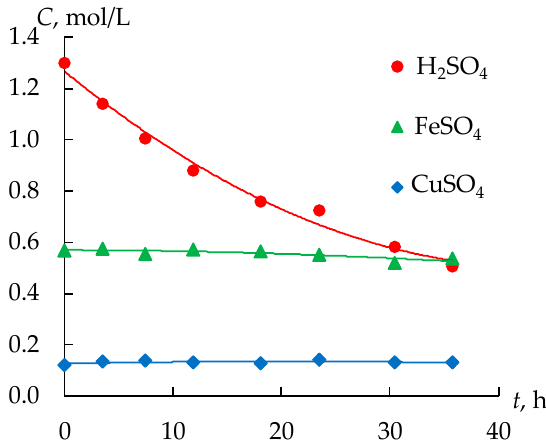
Figure 4. Dependence of the change in the concentrations of components in the feed tank on the time of dialysis.